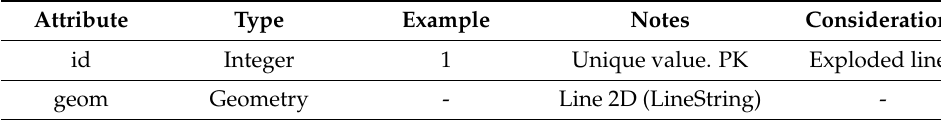
Table A3. GIS attribute table of footpaths.